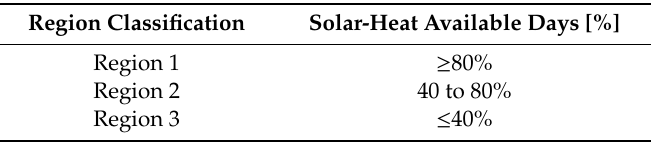
Table 13. Region classification of solar-heat available